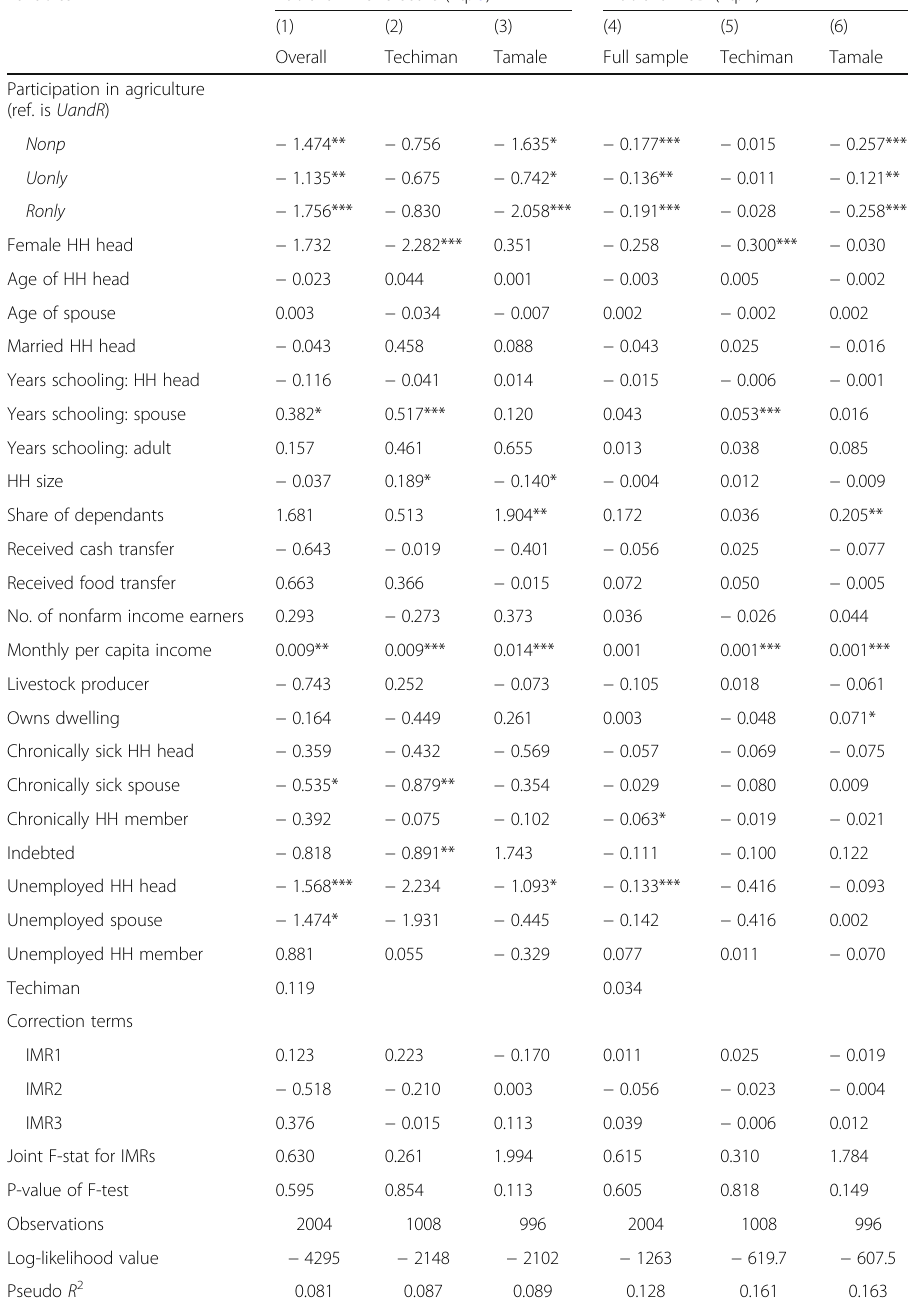
Table 7 Endogeneity corrected estimates of household participation in agriculture and FS (AME)